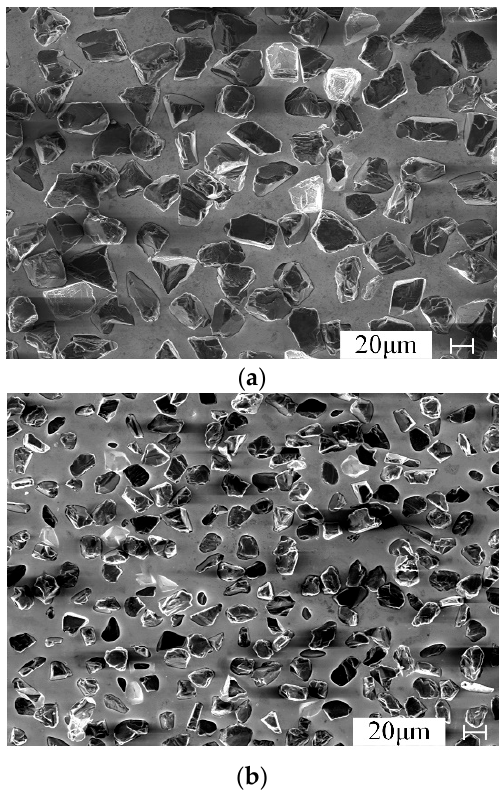
Figure 8. Surface morphology of the CBN wheel with normal wear. ( a ) Surface morphology of 400# CBN wheel, ( b ) Surface morphology of 600# CBN wheel.